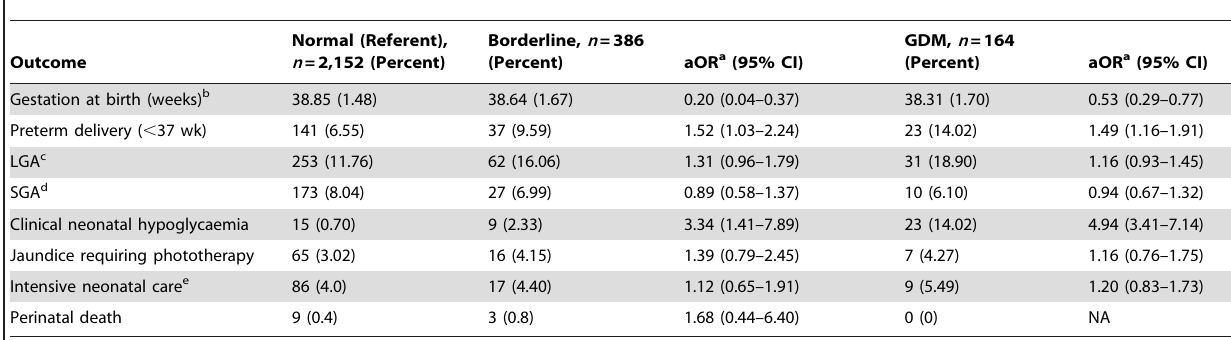
Table 3. Neonatal outcomes comparing referent group to borderline and GDM groups.